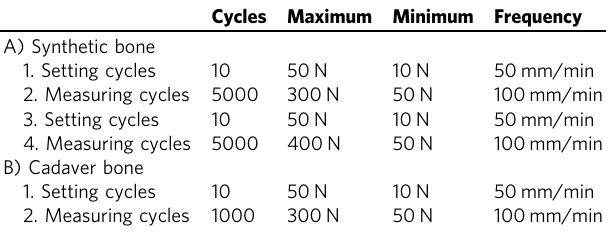
Table 1 A) Material testing protocol used to examine synthetic pelvis models. B) Material testing protocol used to examine cadaver